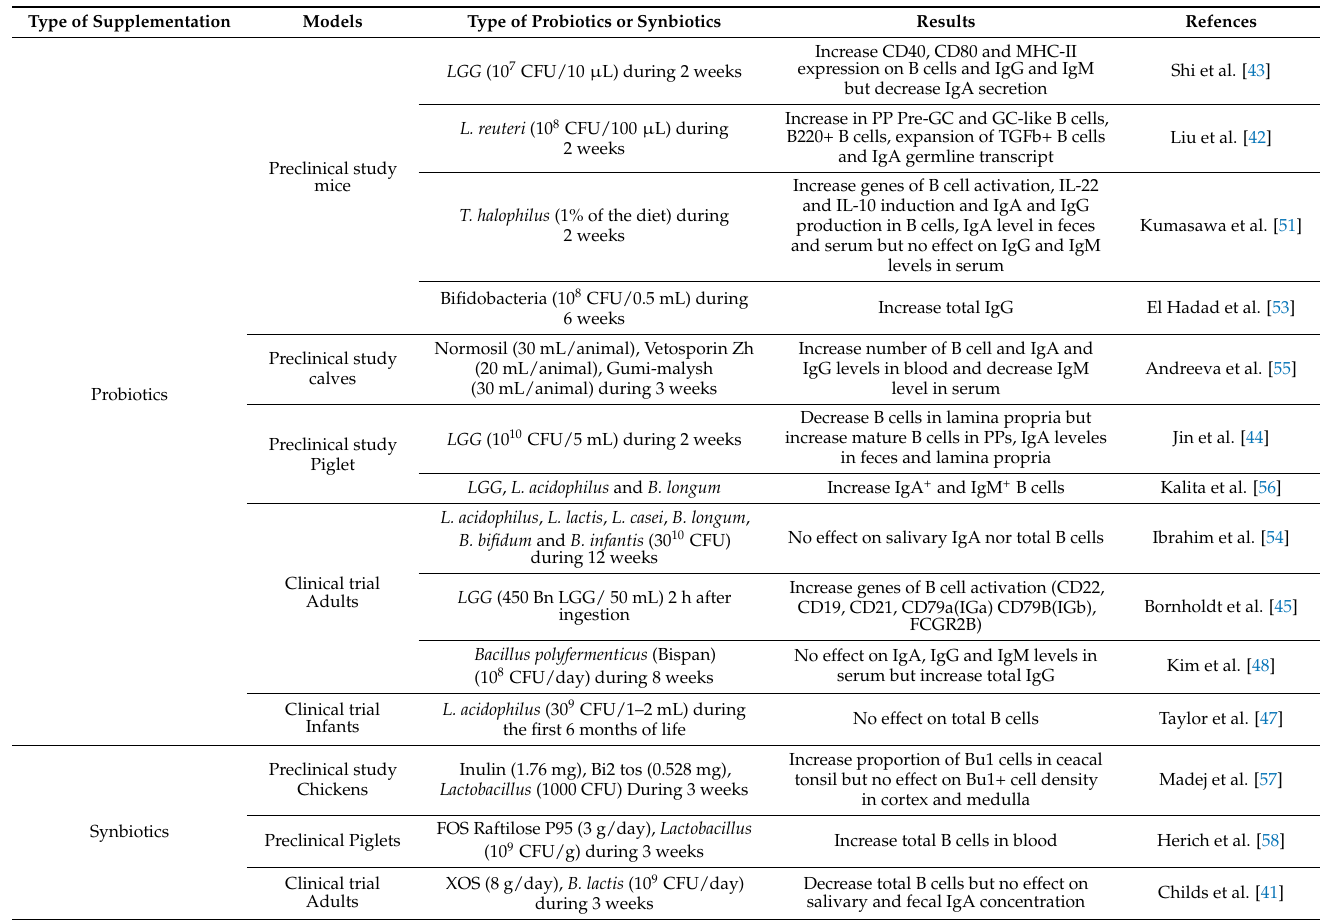
Table 2. Effects of probiotics and synbiotics on immune B lymphocytes in healthy